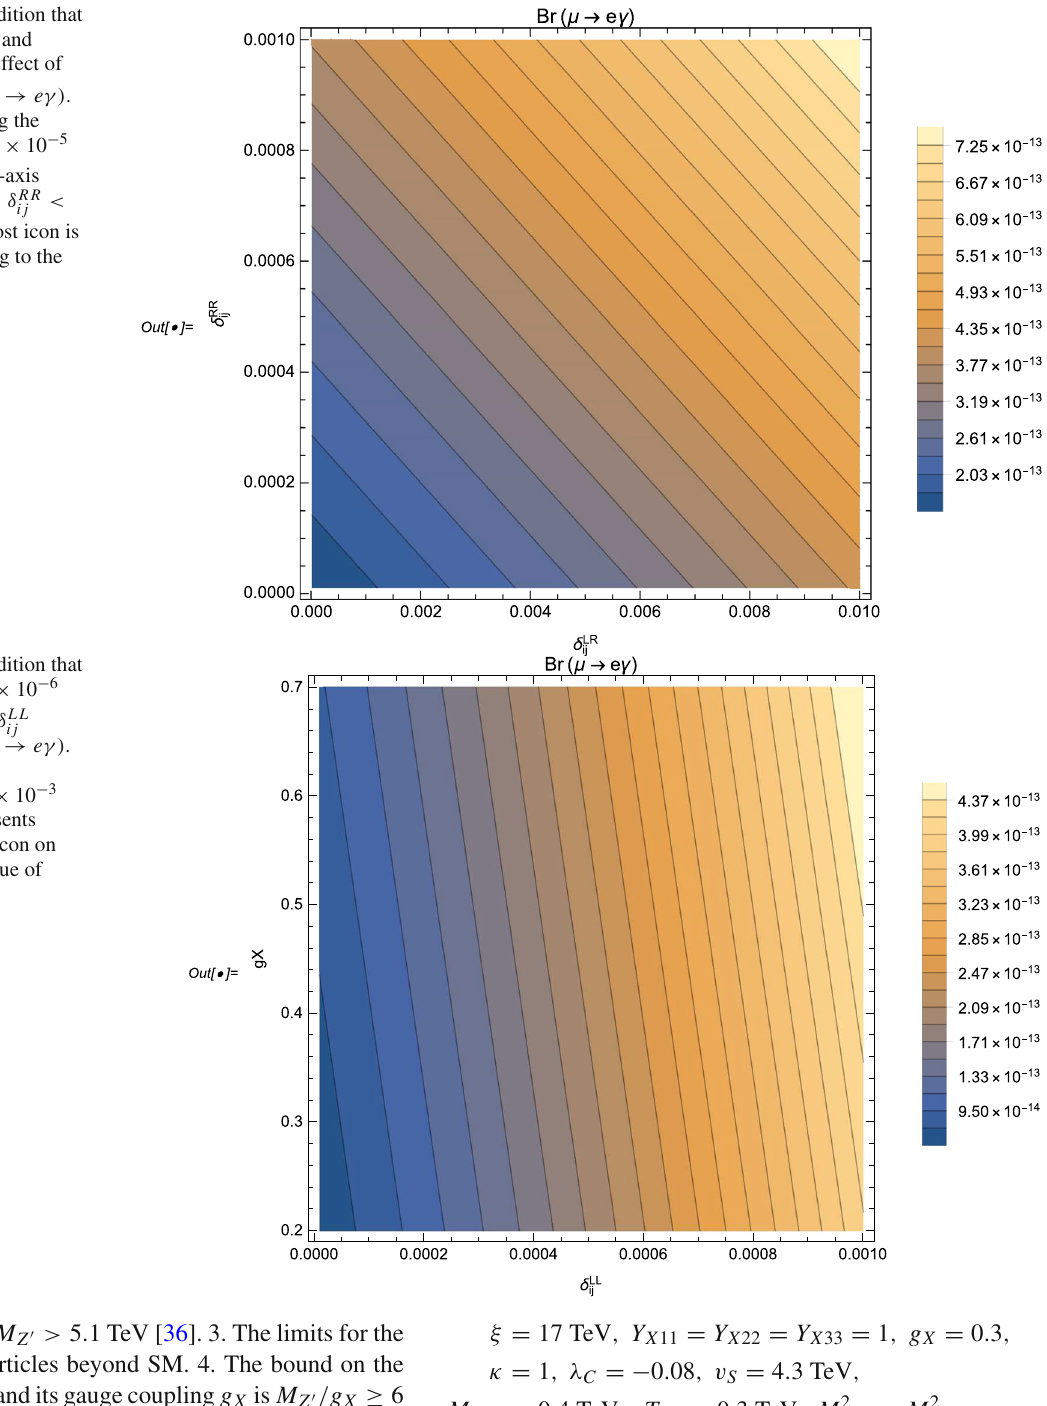
Fig. 2 Under the condition that g YX = 0 . 2 , g X = 0 . 3 and δ LL = 1 × 10 − 3 , the effect of ij δ LR and δ RR on Br (μ → e γ) . ij ij The x-axis representing the range of δ LR is from 1 × 10 − 5 ij to 1 × 10 − 2 , and the y-axis < represents 1 × 10 − 5 < δ RR ij 1 × 10 − 3 . The rightmost icon is the color corresponding to the value of Br (μ → e γ)